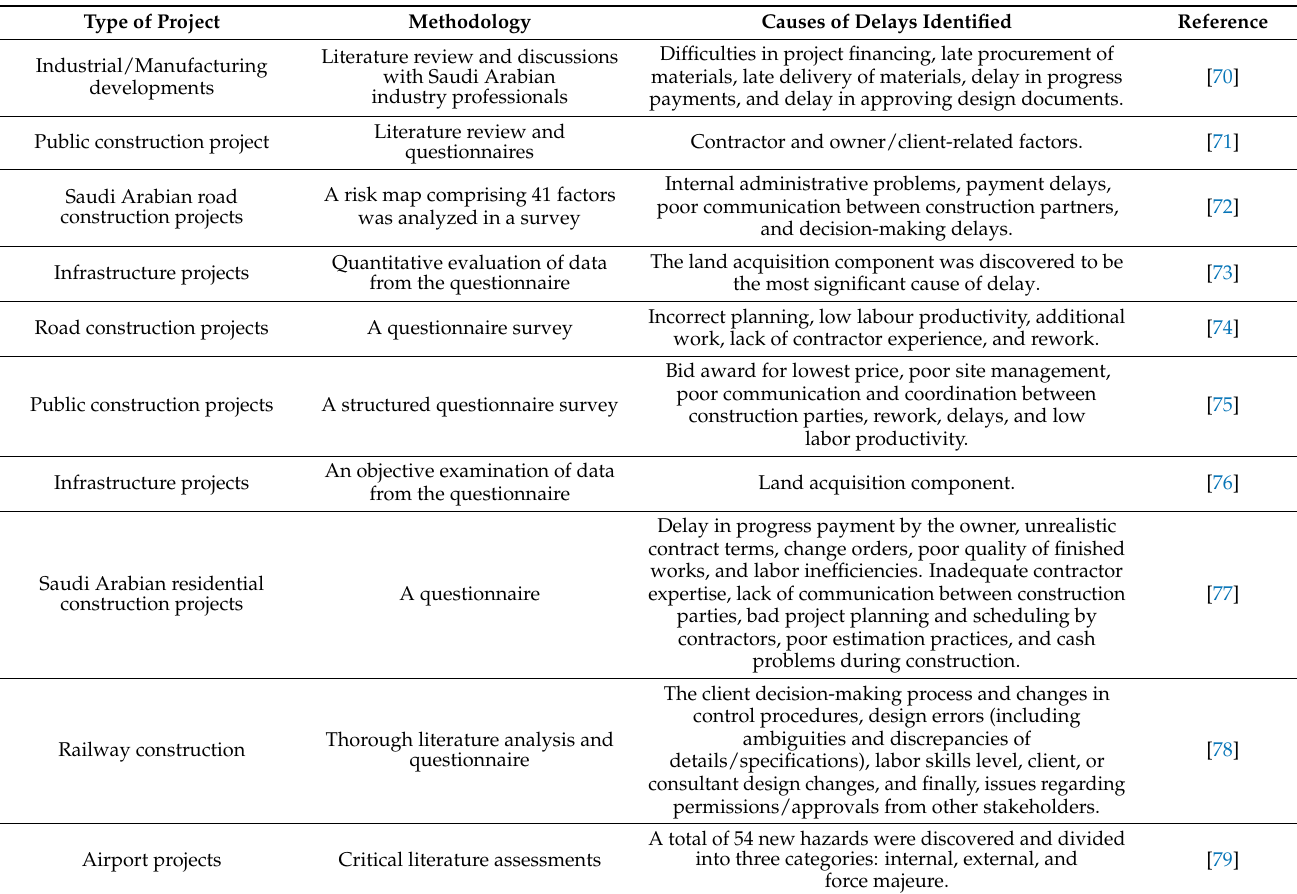
Table 3. Causes of delay in different construction